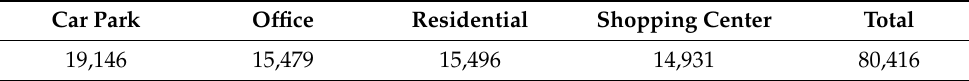
Table 1. The number of charging sessions by types of charging sites used in this study.